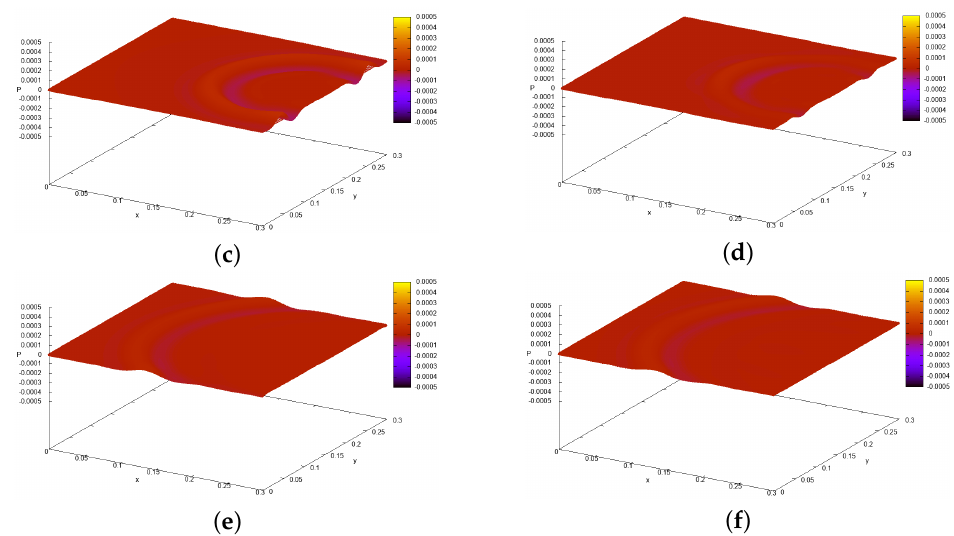
Figure 6. Test 2. Inverse problem 2. Numerical solution. 900 iterations. ( a )—direct problem solution